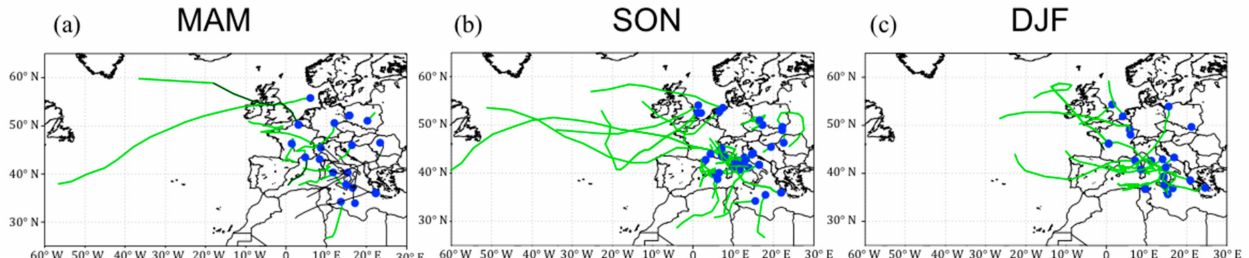
Figure 2. Tracks of tornado extratropical cyclones (TECs) in ( a , left ) spring, ( b , middle ) autumn, and ( c , right ) winter. Blue dots indicate the locations of TECs at key time (KT), while green lines the tracks of TECs from KT-96 h to